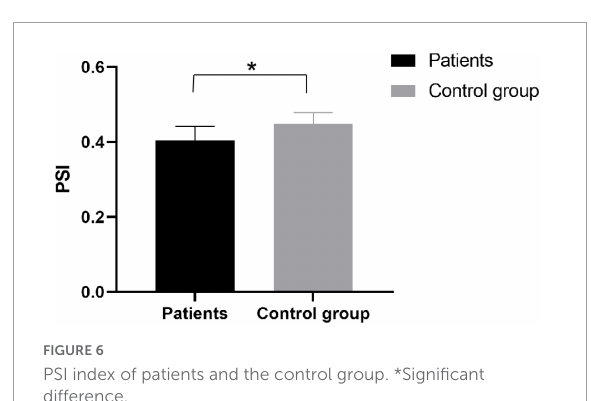
FIGURE5 ERD index of patients and the control group.